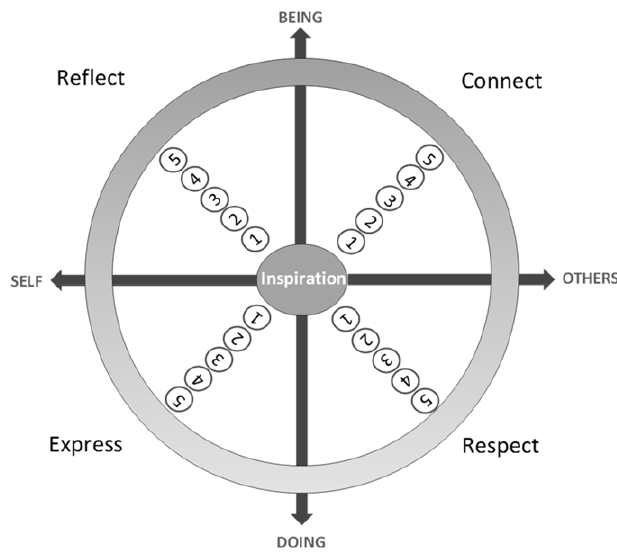
Figure 3. Distance travelled and Meaningful Evaluation